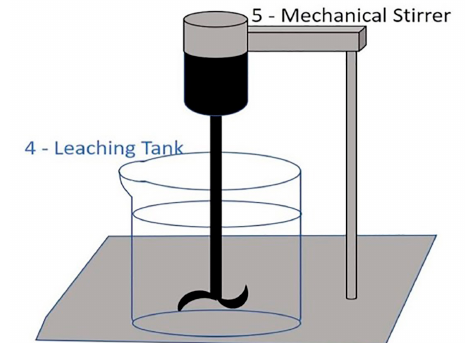
Figure 5. Schematic drawing of the leaching tank in water; Where: 4 leaching tank having water as a leaching agent and 5 mechanical stirrer at the speed of 620 rpm.